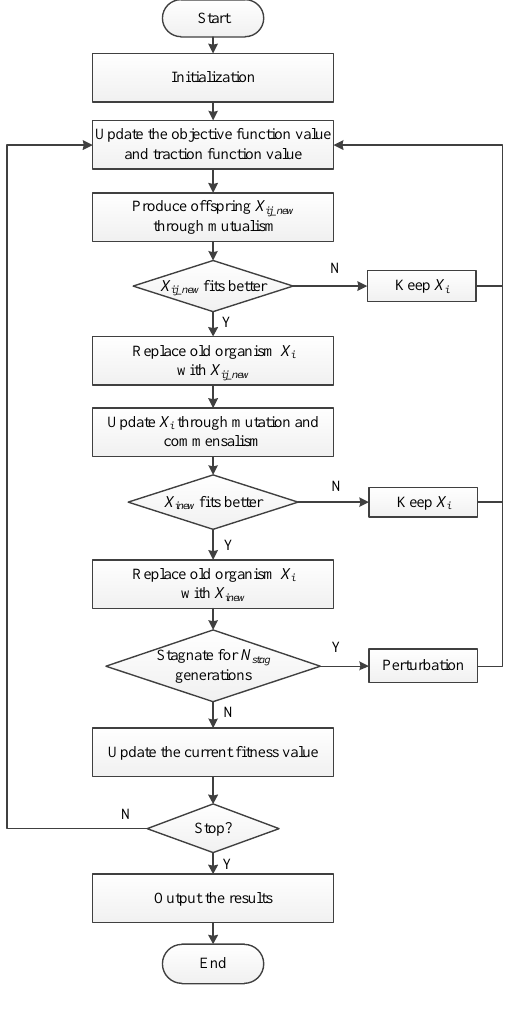
Figure 2. Flowchart of